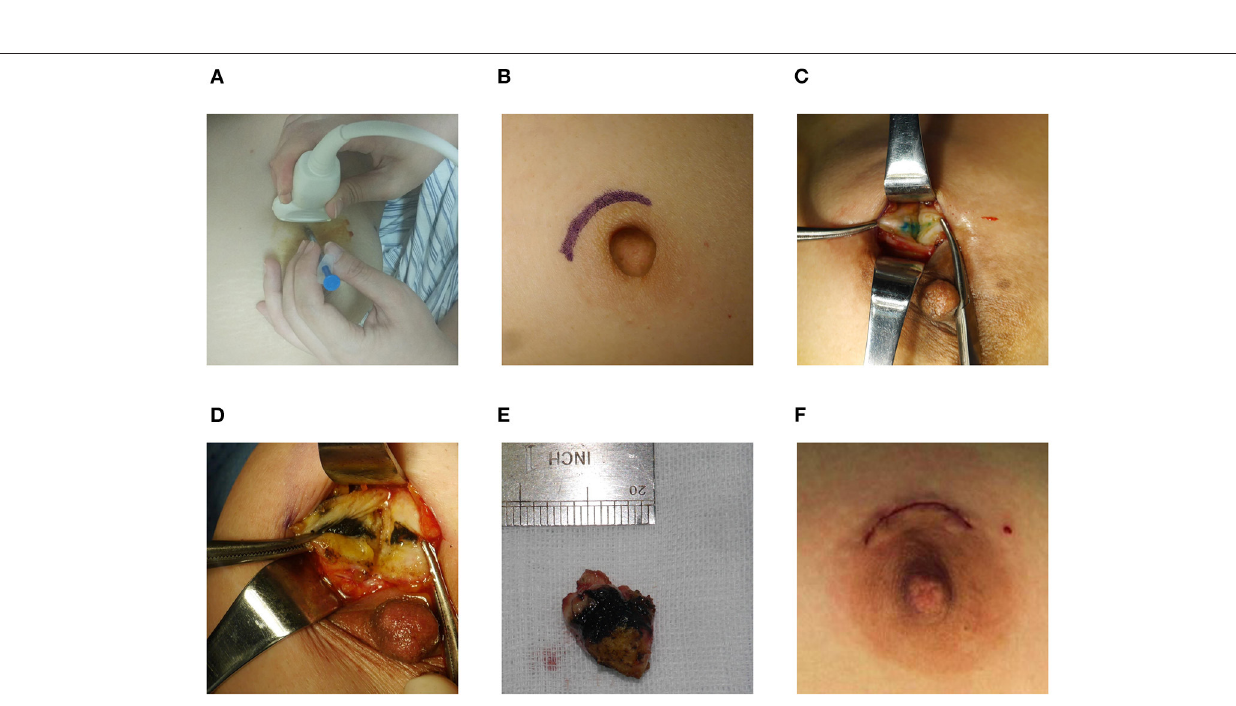
FIGURE 2 | Surgical procedure. (A) Preoperative localization. (B) Periareolar incision. (C,D) Dyeing track. (E) Resection tissue. (F) Intradermal sutured incision.